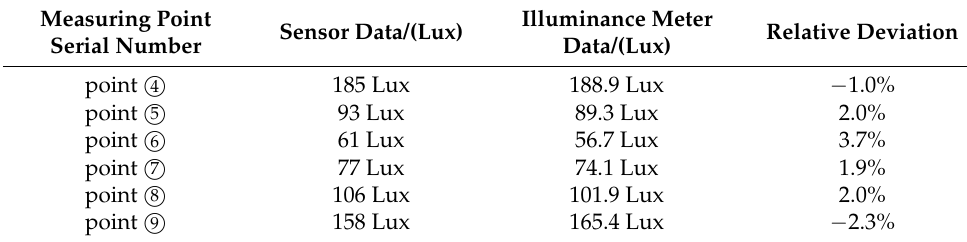
Table 5. Data comparison table of the device and